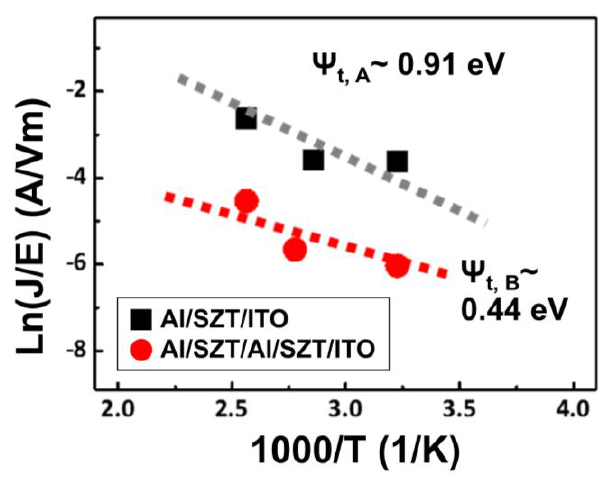
Figure 6. ln(J/E) as the function 1/T of the Al/SZT/ITO and Al/SZT/Al (18 nm)/SZT/ITO structure.